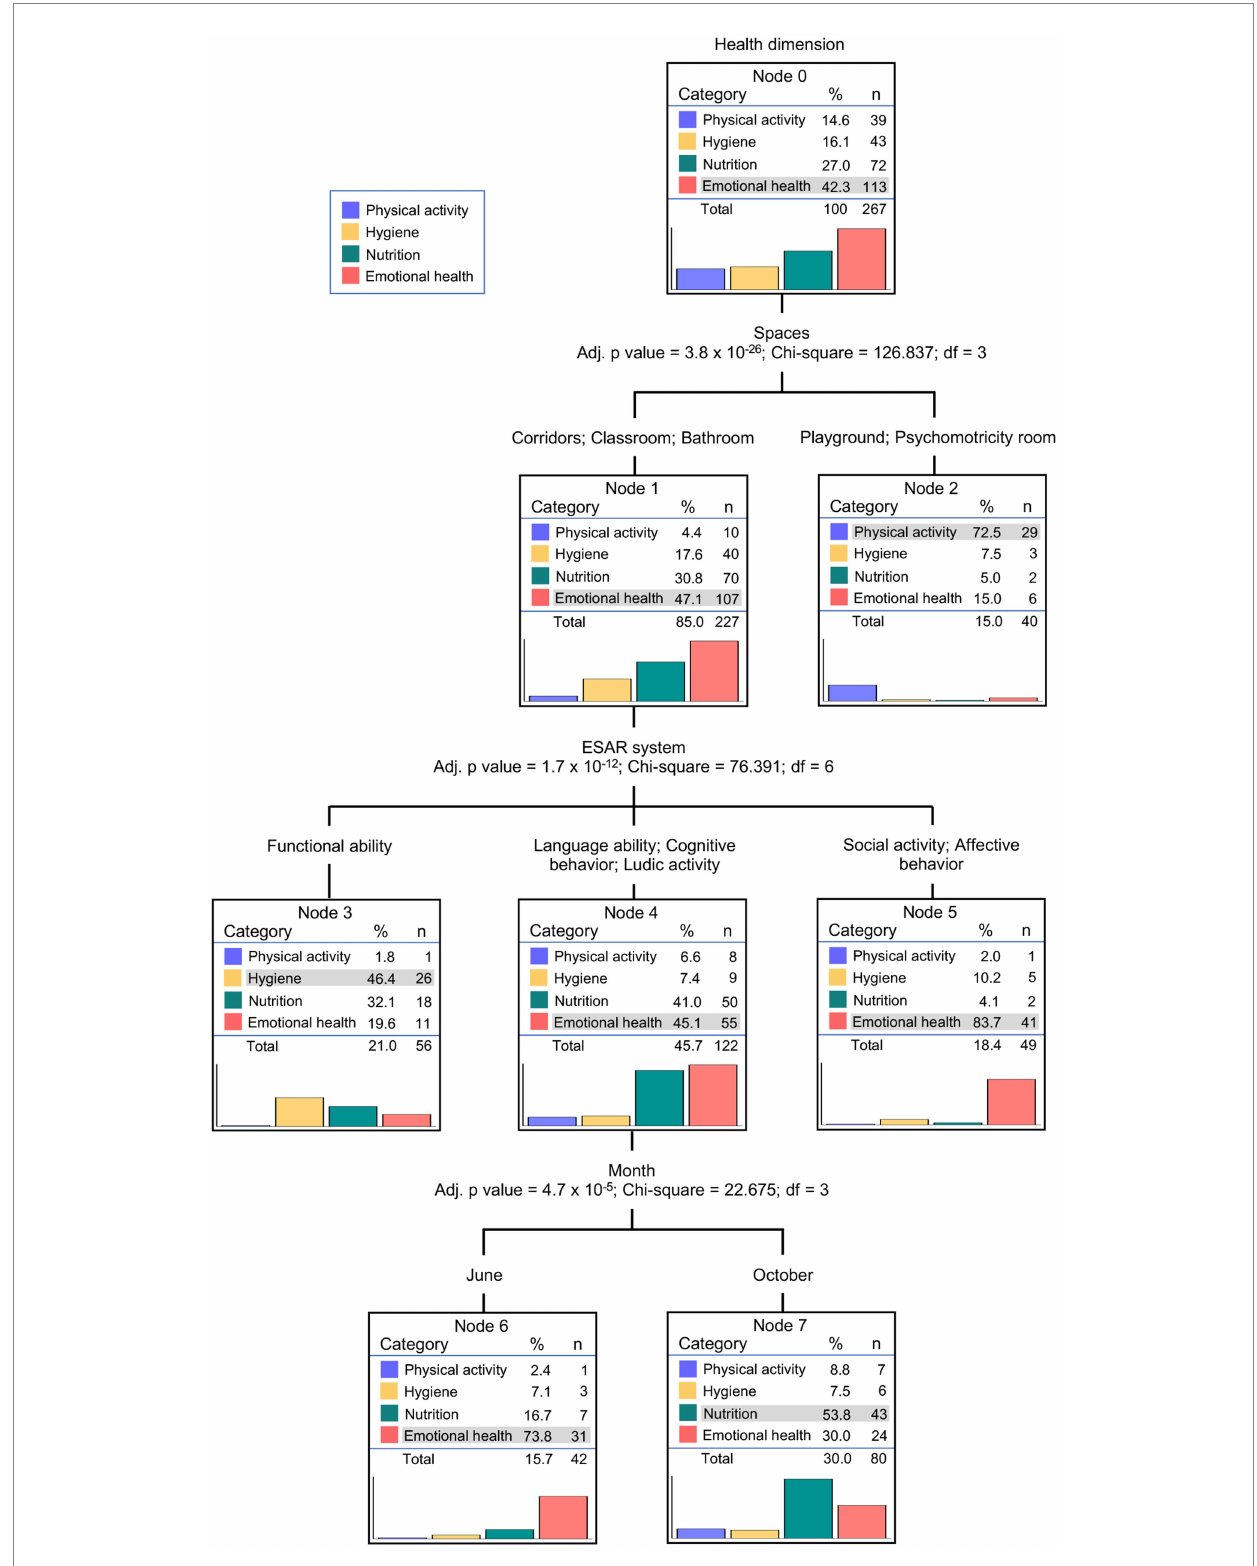
FIGURE 2 Classification tree using the exhaustive Chi-square automatic interaction detection (CHAID) algorithm to predict the patterns of the pedagogical actions of teachers in the promotion of children’s healthy